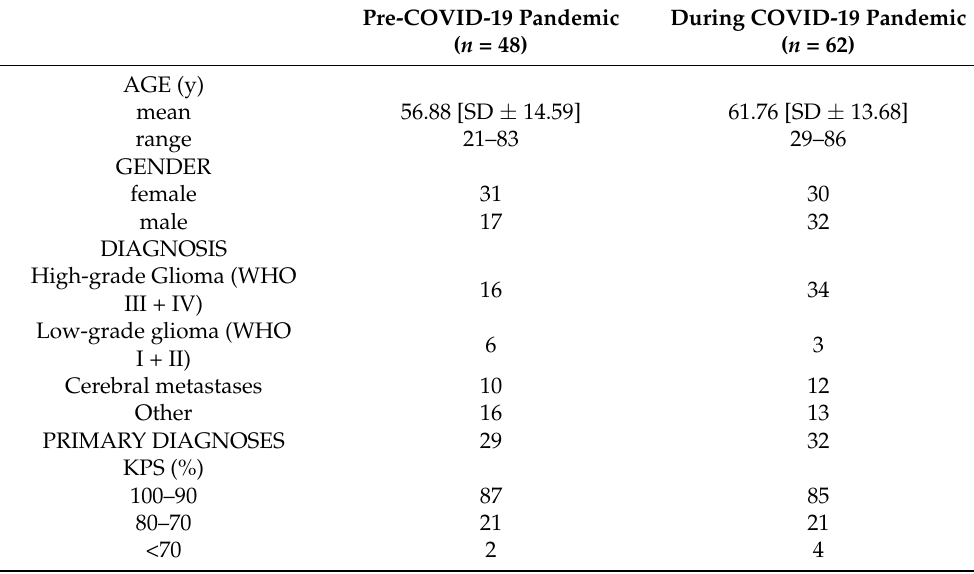
Table 1. Descriptive epidemiologic data of patient